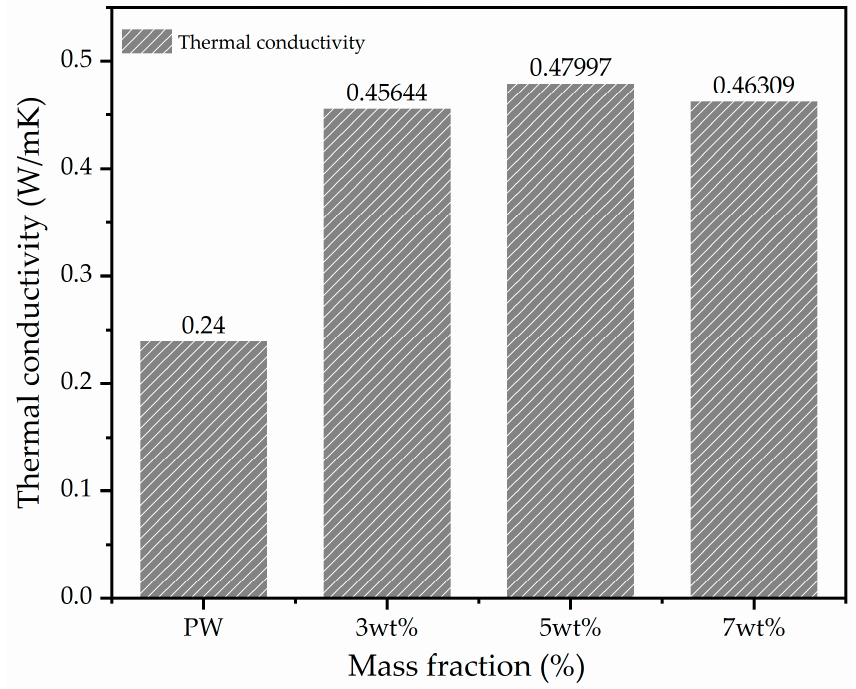
Figure 6. Thermal conductivity of PCM composites and PW.